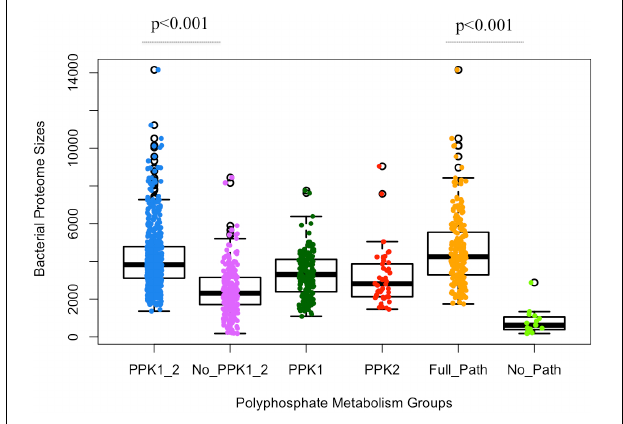
FIGURE 2 | Statistical analysis of polyphosphate metabolism abilities and bacterial proteome sizes via boxplots overlaid with dots. X -axis shows the six previously described polyP groups. Y -axis indicates the number of proteins in a proteome. Each circled dot represents a single bacterium. Proteome sizes of PPK1_2/No_PPK1_2 and Full_Path/No_Path show statistically significant differences between each other, respectively. Unpaired two-tailed Student’s t -test was used ( p -value <